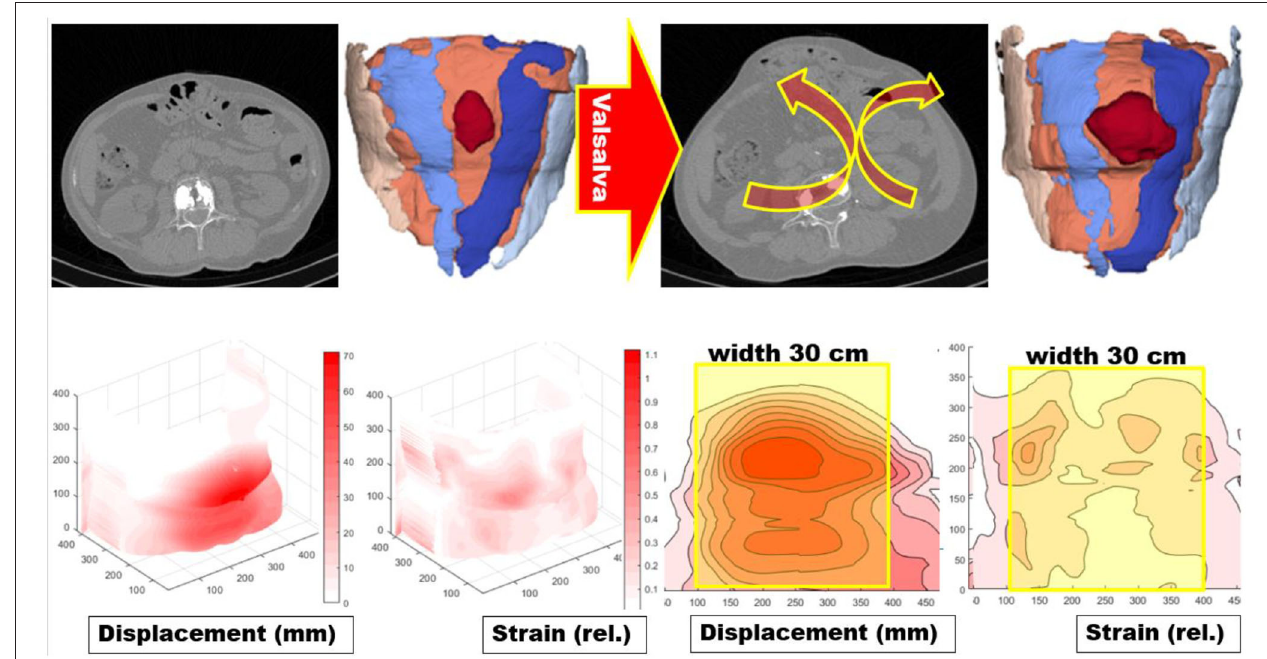
FIGURE 8 | (Top from left to right) a scan central to the incisional hernia of a CT abdomen at rest, analysis of the data with artificial intelligence giving the rectus muscles as blue areas and marking the hernia with a dark red color ( 10). The application of Valsalva’s maneuver unmasks a regional instability of the abdominal wall with an outward motion marked with the red arrows with the yellow borders. The resulting hernia orifice enlarges and changes its shape. (Bottom from left to right) Surface displacement of the abdominal wall during Valsalva’s maneuver in millimeters and the resulting strain field in 3 D and as a planar projection (11). On the planar projections, a hernia mesh 30cm wide and 45cm long is superimposed with the center at the umbilicus. It was evident that stress concentrations and peaks of distortions can occur at the edge of the mesh resulting in an unstable